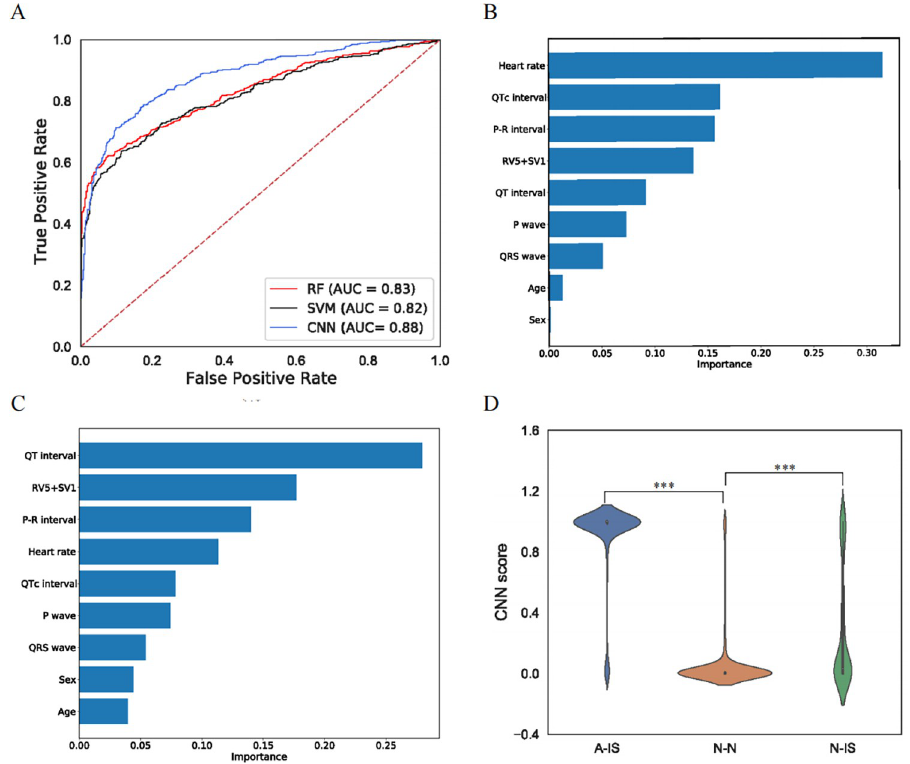
Fig 3. Performance of the ML and CNN models. (A) Comparison of receiver operating characteristic (ROC) curves of the CNN model and 2 ML models (RF and SVM). The area under the ROC curve (AUC) of the CNN model (0.88, 95% CI = 0.86–0.90) was higher than that of the RF model (0.83, 95% CI = 0.81–0.85) and SVM model (0.82, 95% CI = 0.80–0.84), indicating the best performance in classification. (B) Variables used to build the RF model are ranked according to their importance. Heart rate is ranked as the most important variable for classification. (C) In the SVM model, the QT interval is ranked as the most important variable for classification among the demographics and ECG parameters. (D) The score distribution of the N-N, N-IS and A-IS datasets was evaluated by the CNN model. The scores of the A-IS dataset are concentrated around 1, while the scores of the N-N dataset are concentrated near 0. The scores of the N-IS dataset do not show an overt central tendency. The scores between the N-N and N-IS datasets are significantly different ( p < 0.001, Wilcoxon rank-sum test), as are the scores between the A-IS and N-IS datasets. ( p < 0.001, Wilcoxon rank-sum test). Note: p < 0.05; � , < 0.01, �� ; < 0.001, ���